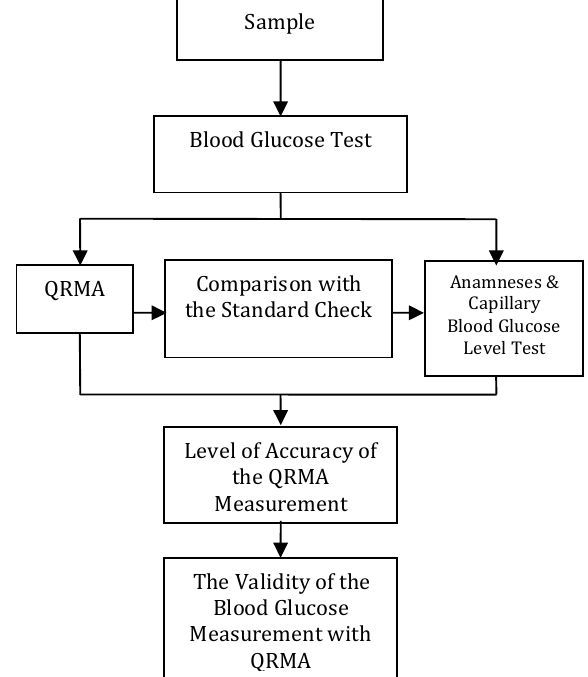
Figure 1. Research